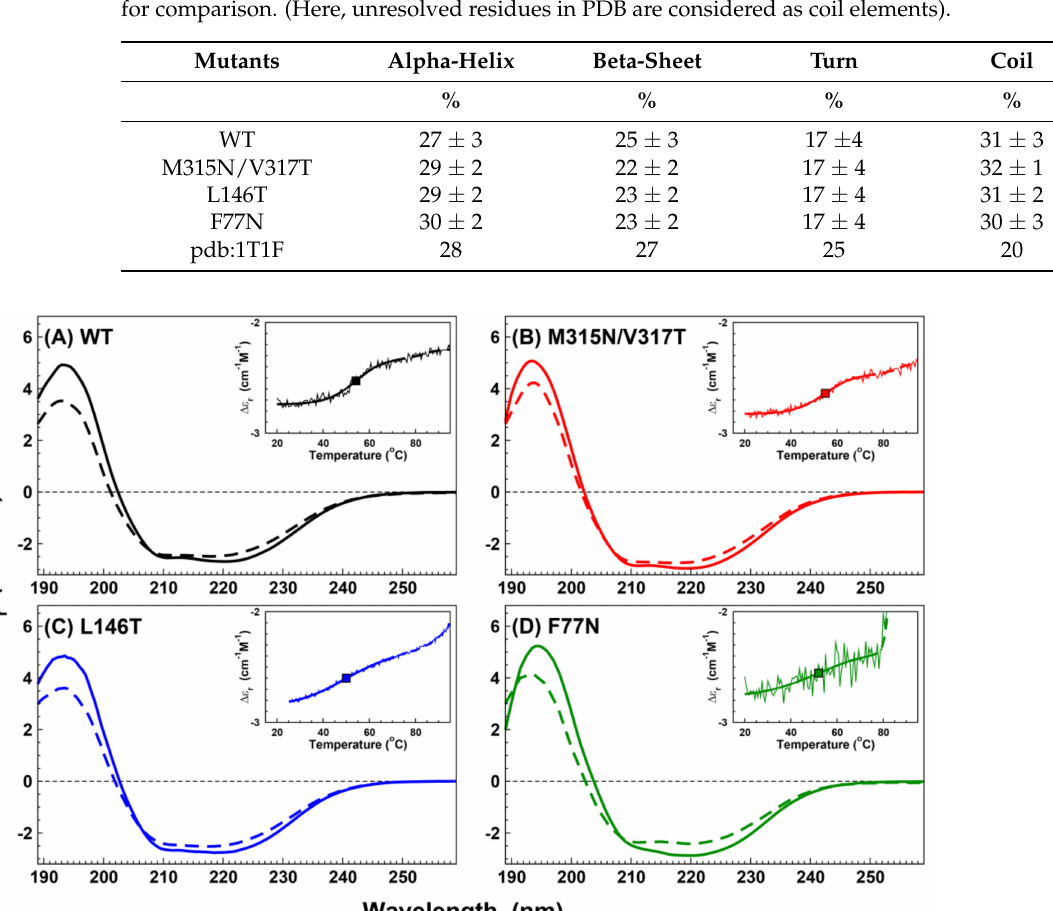
Figure 4. Secondary structures of the antithrombin mutants. Circular dichroisms (CD) spectra of wild type beta-antithrombin (S137A) ( A ) and mutants M315N/V317T ( B ), L146T ( C ), and F77N ( D ) for antithrombin monomers (solid curves) and polymers (dashed curves). Insets: CD signal at 221 nm on a thermal ramp (light curves); data are fitted here with sigmoidal curves (bold solid curves); the mid-point temperatures, shown as squares, are 54, 55, 50, and 52 ◦ C for the wild type, M315N/V317T, L146T, and F77N, respectively; the onset of a second sigmoidal curve at higher temperatures indicates the onset of unfolding (dashed